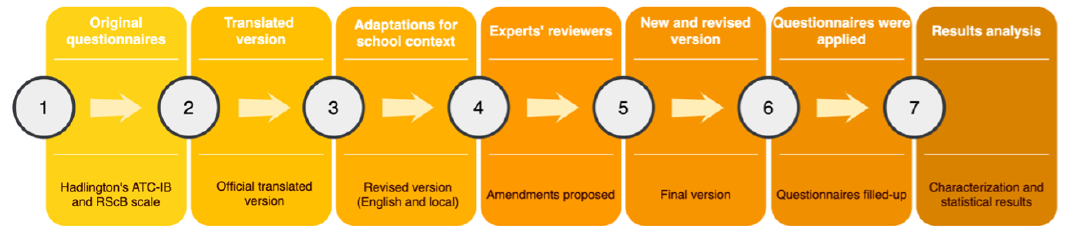
Figure 2. Overall methodology applied on questionnaire